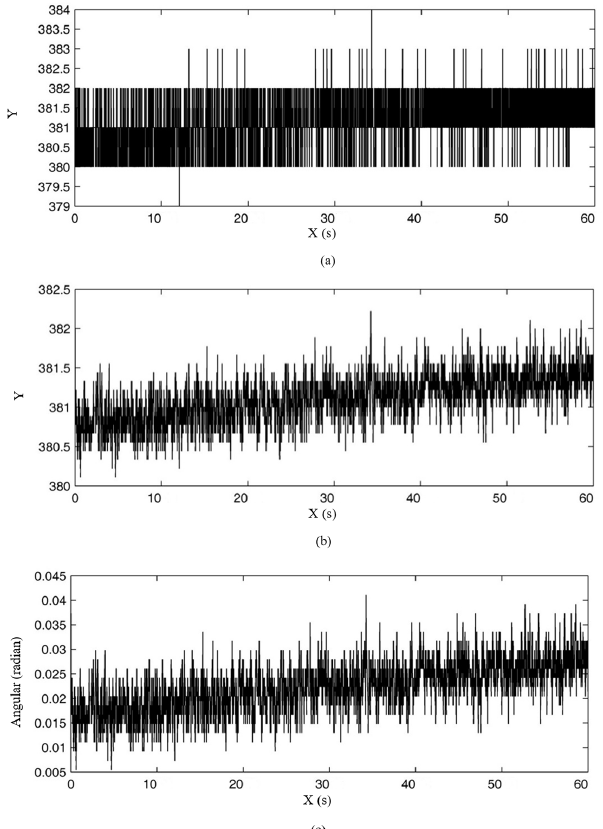
Figure 4. Static placement measurement results of the gyroscope. (a) Digital output of the ADC for the gyroscope. (b) Processed data by the combined median and mean filter. (c) Converted angular rate for gyroscope